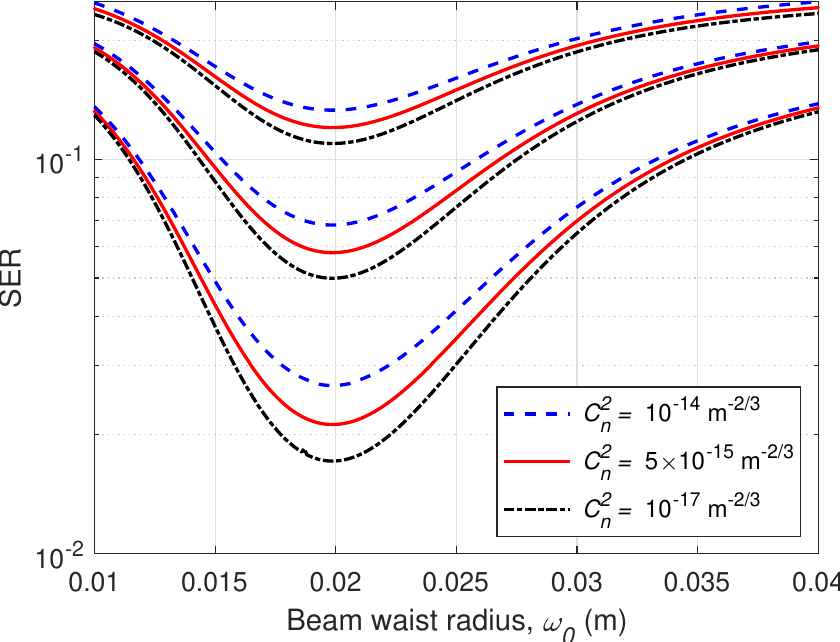
Figure 6. SER versus beam waist radius, ω 0 , for different values of turbulence strength with a transmission link length of 800 m, different values of turbulence strength and various values of the pointing error displacement standard deviation σ s = 0.05, 0.07, and 0.1 (from bottom to